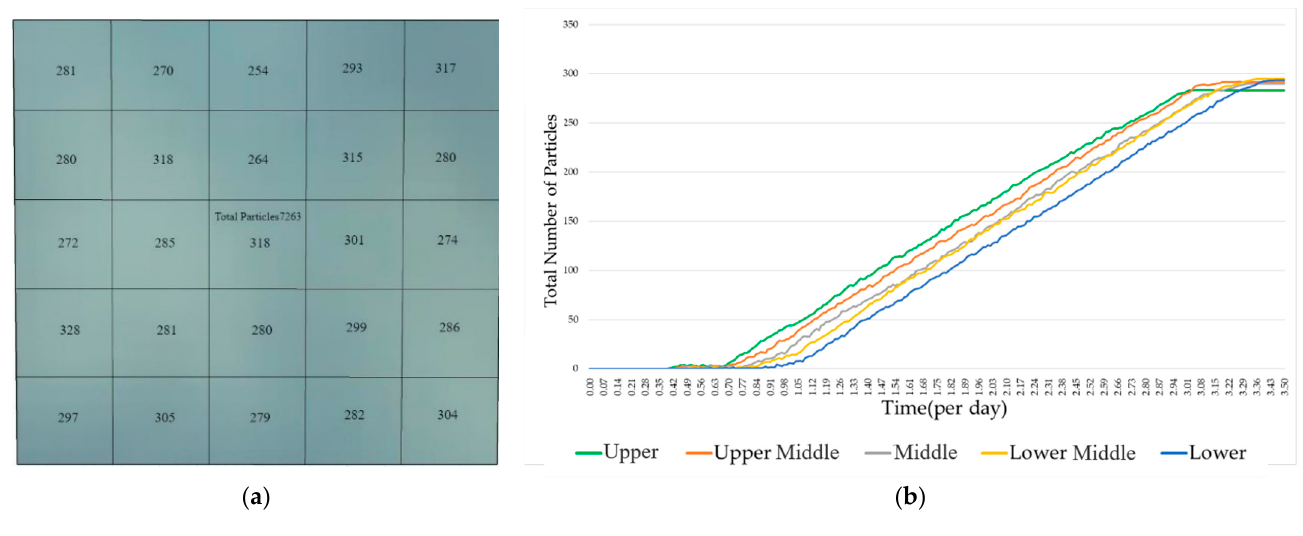
Figure 5. Dust particle distribution at an inclination angle of 20°. ( a ) The total number of particles in each area and ( b ) that over time on the solar panel surface.